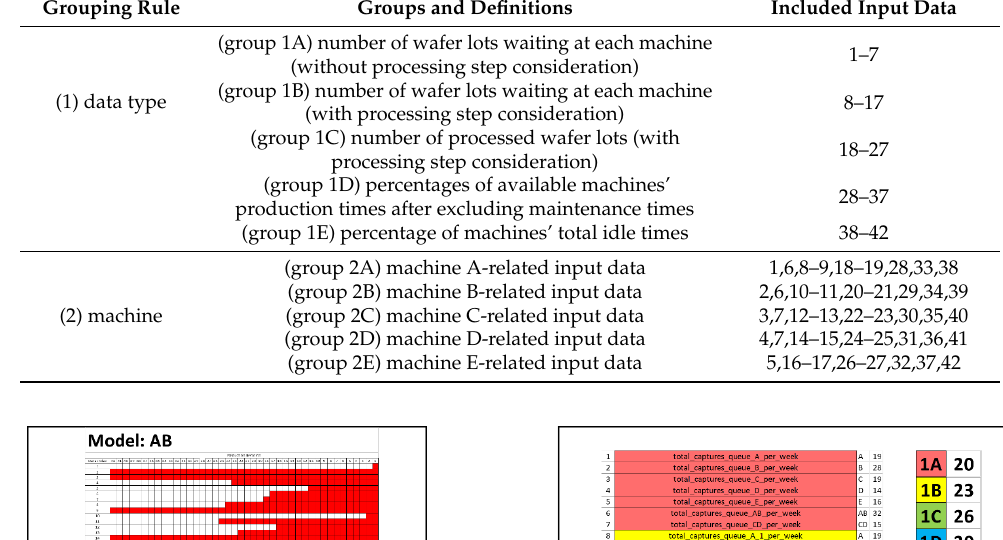
Table 7. Input data groups based on (1) data type and (2) machine-related data information.